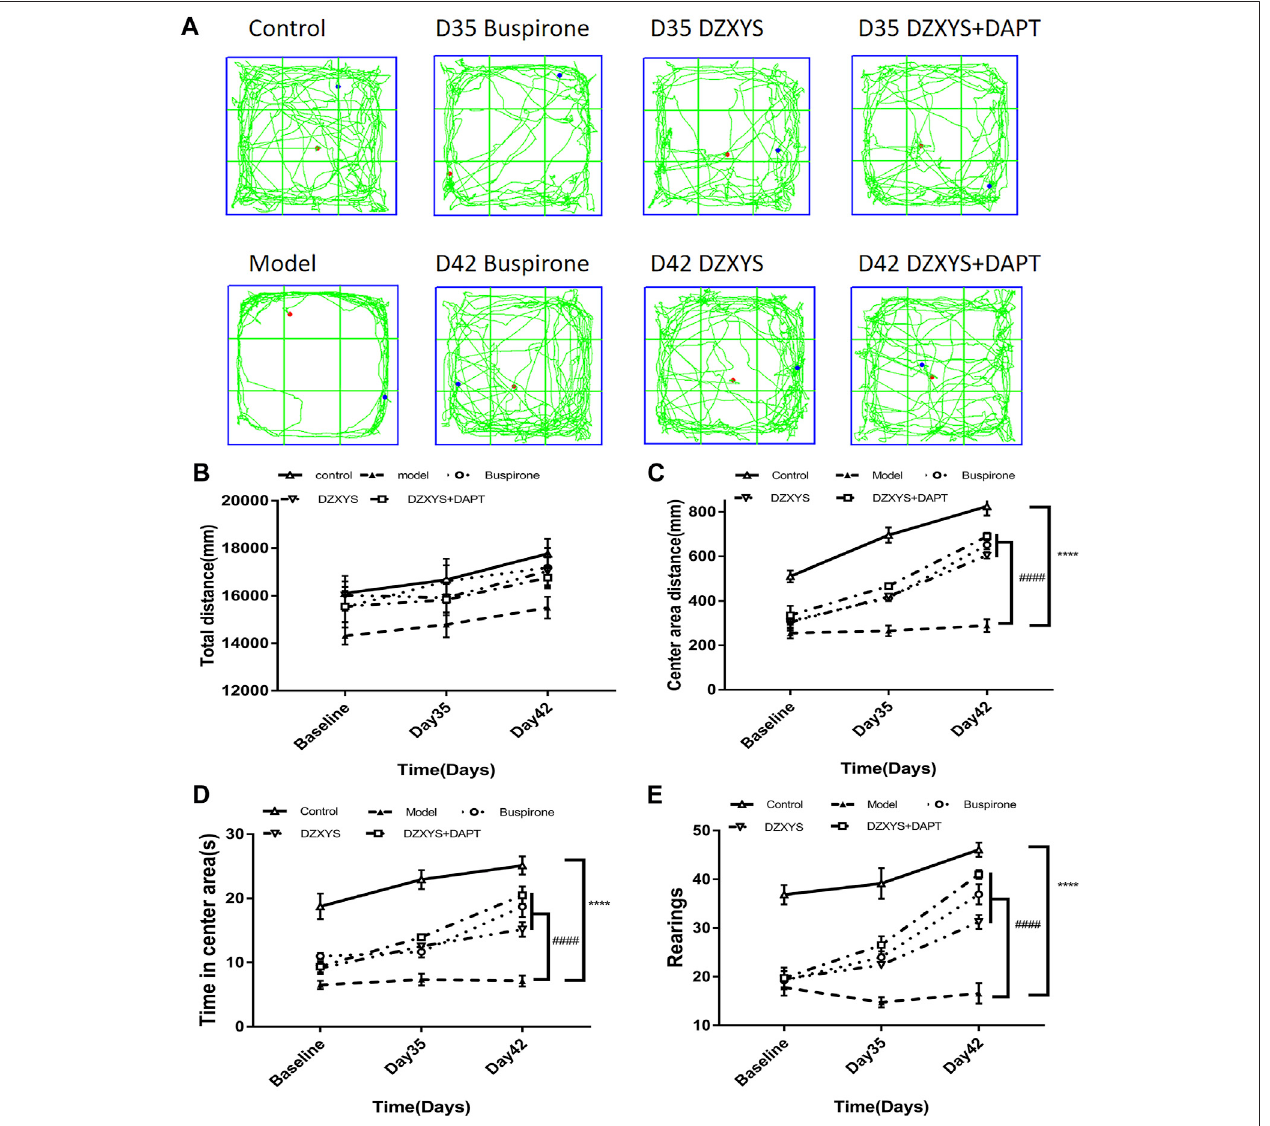
FIGURE4| ShowstheresultsoftheOFTexperiment (A) ThetrajectoryofOFTineachgroup (B) Totaldistance(mm)traveledina6 minperiod (C) Centerareadistance (mm) (D) Time in center area(s) (E) Number of rearings. **** p < 0.0001 vs control group. #### p < 0.0001 vs. model group, repeated measurements of two-way ANOVA.